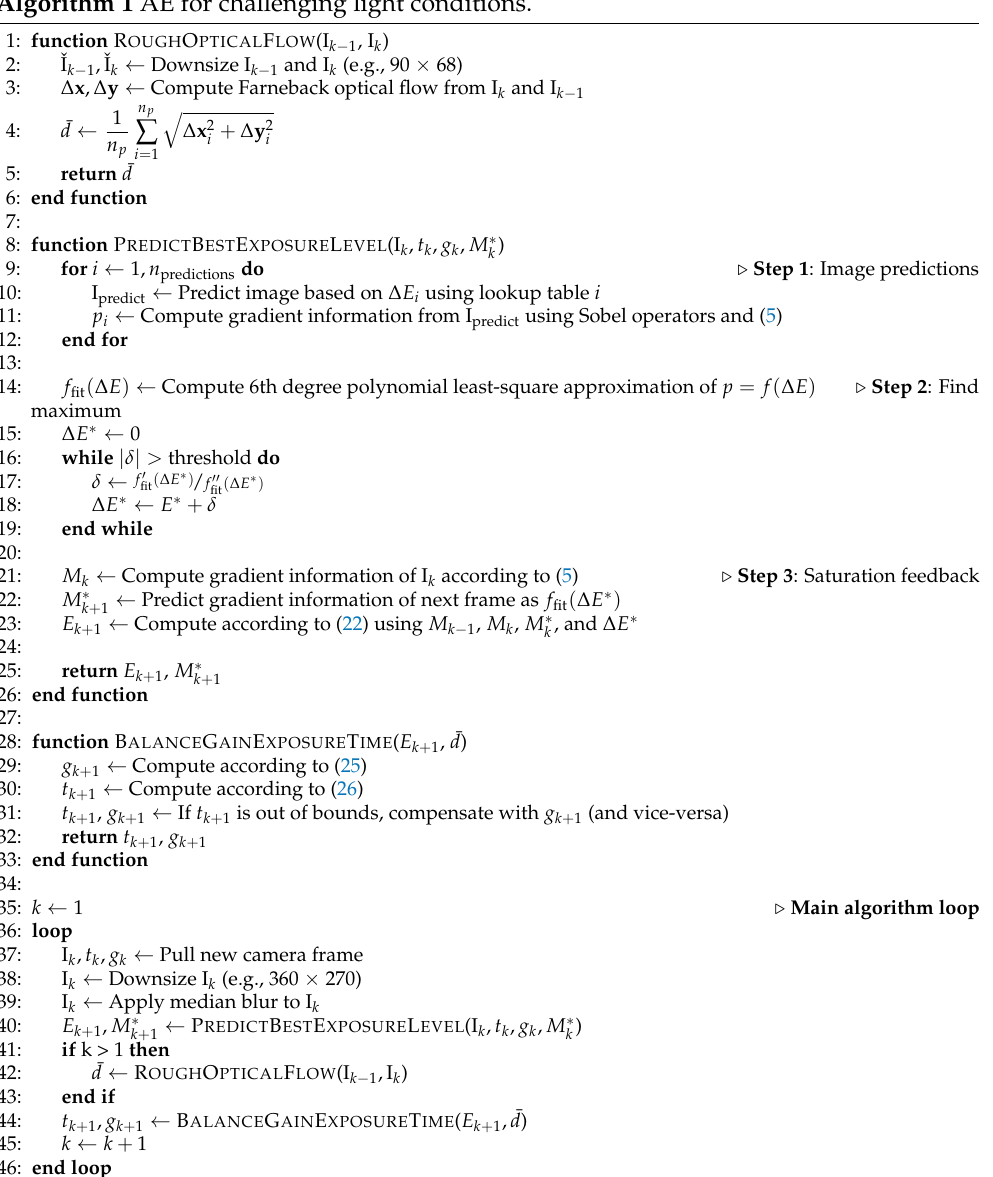
Algorithm 1 AE for challenging light